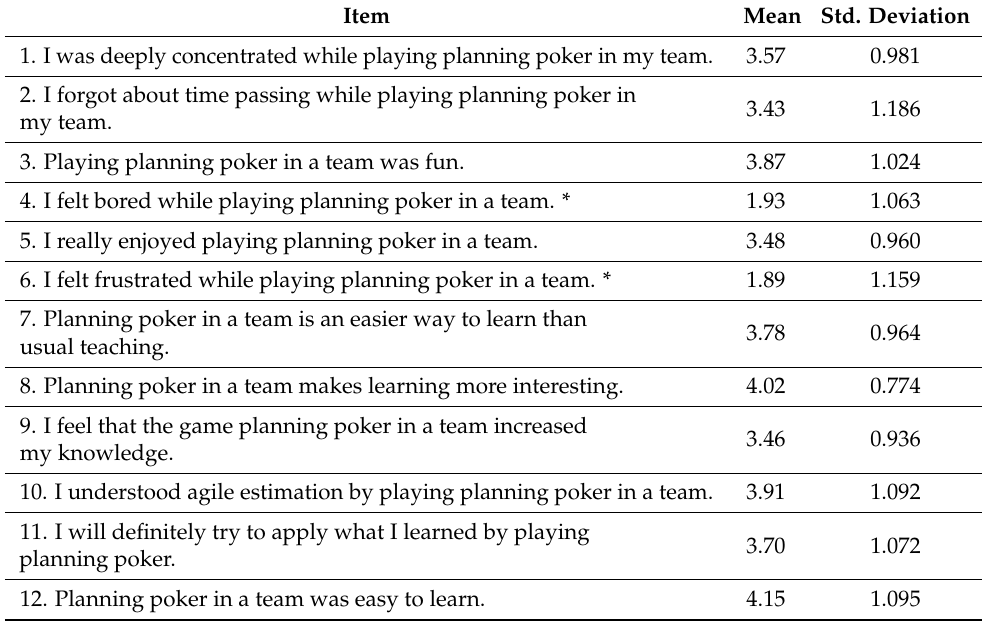
Table 3. Item statistics of the shortened Learning Experience Scale, n = 46. Rating on a five-point scale: “Strongly Agree” (5), “Agree” (4); “Neutral” (3); “Disagree” (2); ”Strongly Disagree” (1). Item Mean Std.